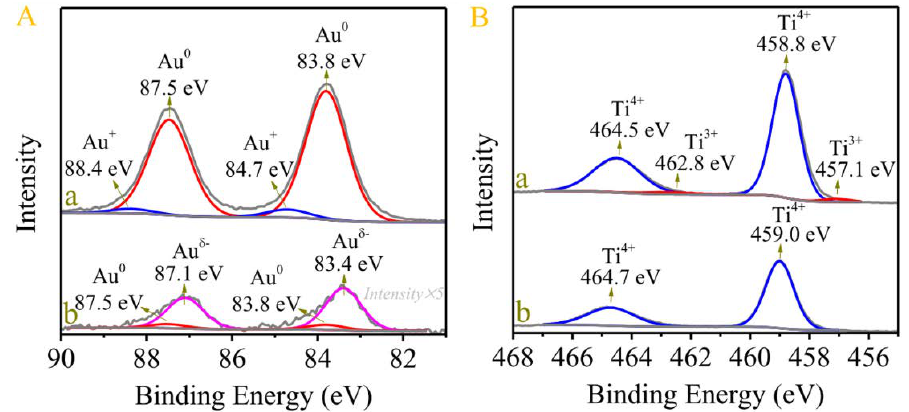
Figure 4. ( A ) Au4f XPS spectra of Au nanoparticles ( a ) pretreated with O 2 and ( b ) interacted with Ti 3 + ; ( B ) Ti2p XPS spectra of the ( a ) as-synthesized TiO x colloid and ( b ) interacting with Au nanoparticle colloid. Reprinted with permission from Reference [37]. Copyright 2019,